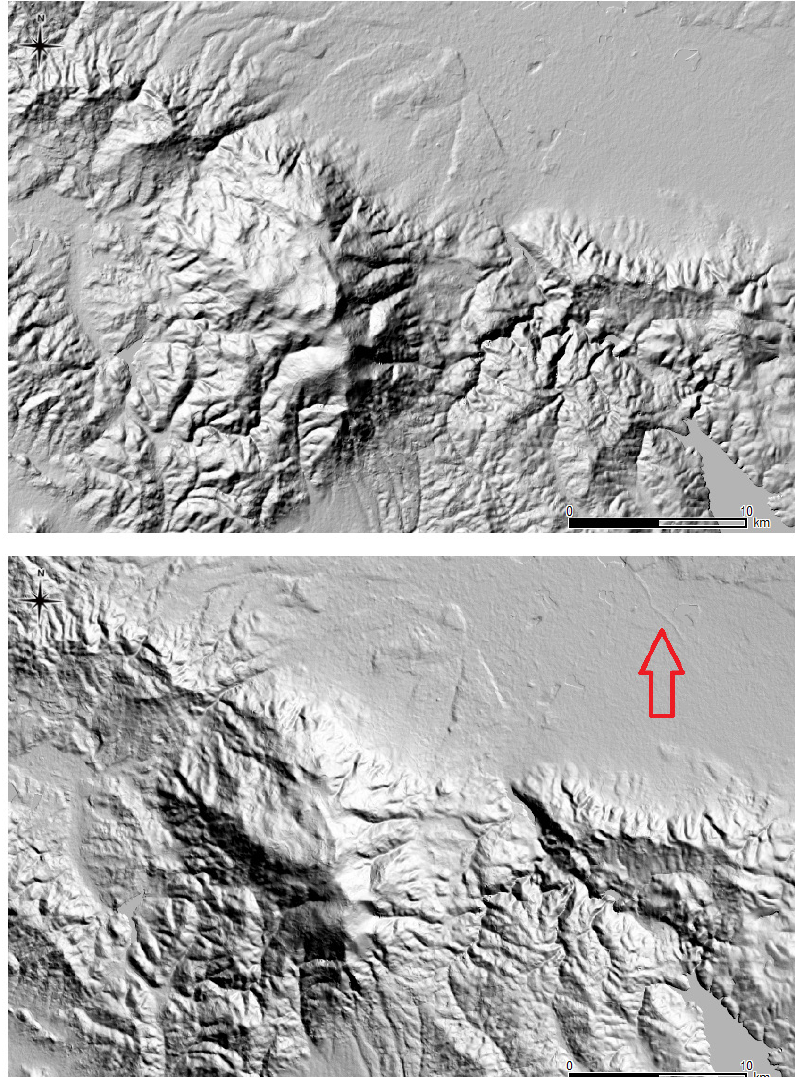
Fig. 1. Hillshade one direction 315 degrees (top) and hillshade one direction 45 degrees